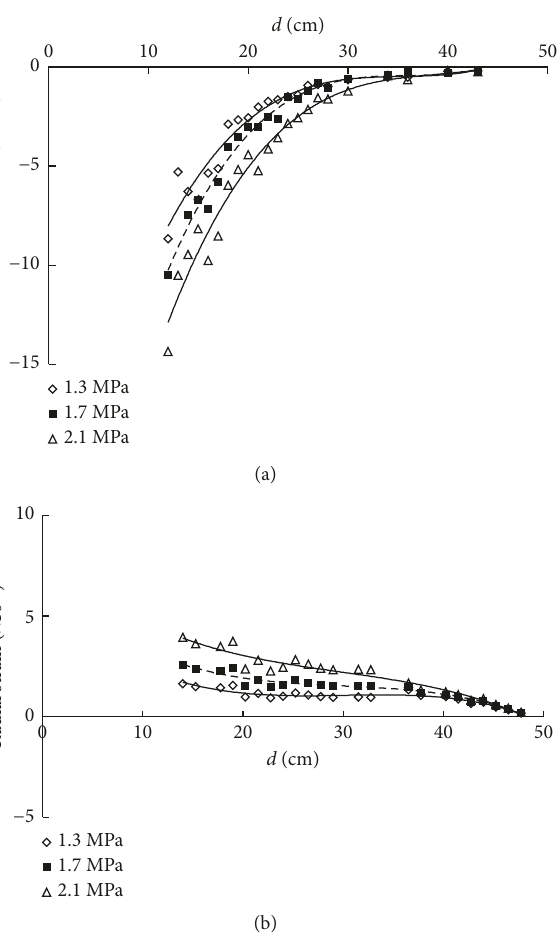
Figure 17: Strain test results of the CC pavement structure model under the different load levels. (a) Circumferential strain. (b) Radial